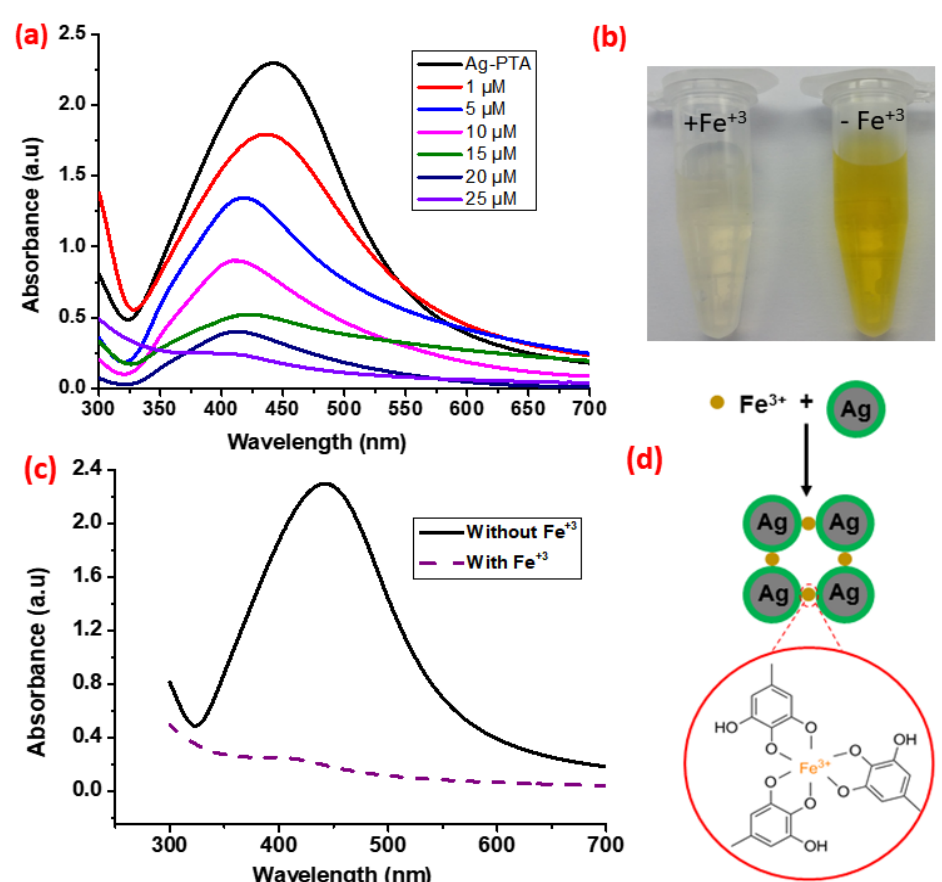
Figure 9. The assay for visual detection of Fe 3+ ions: ( a ) UV–vis spectra obtained from solutions of synthesized silver nanocomposites; ( b ) photographs of the solution containing functionalized silver nanocomposites (right) and the same solution after the addition of Fe 3+ ions (25 μ M; left); ( c ) UV–vis spectra of aqueous dispersion of synthesized silver composites alone and after 03 min in the presence of Fe 3+ ions. Solid line: silver nanocomposites without Fe 3+ , dotted line: silver nanocomposites with Fe 3+ ions; ( d ) coordination of Fe 3+ ions with poly(tannic acid) shell of the synthesized silver nanocomposites.